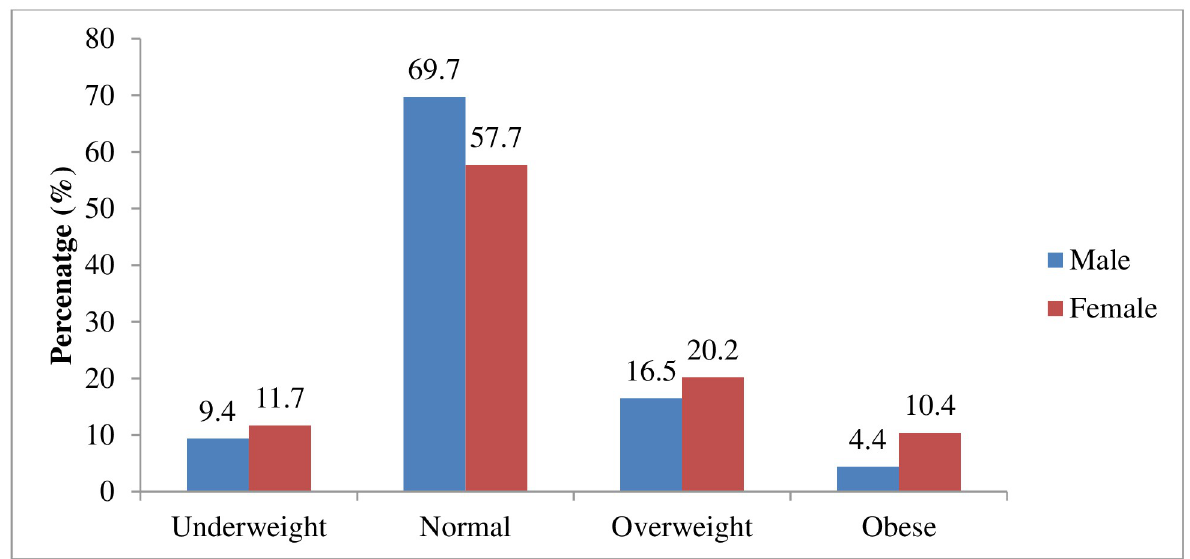
Fig 2. BMI categories according to the sex of students in the University of